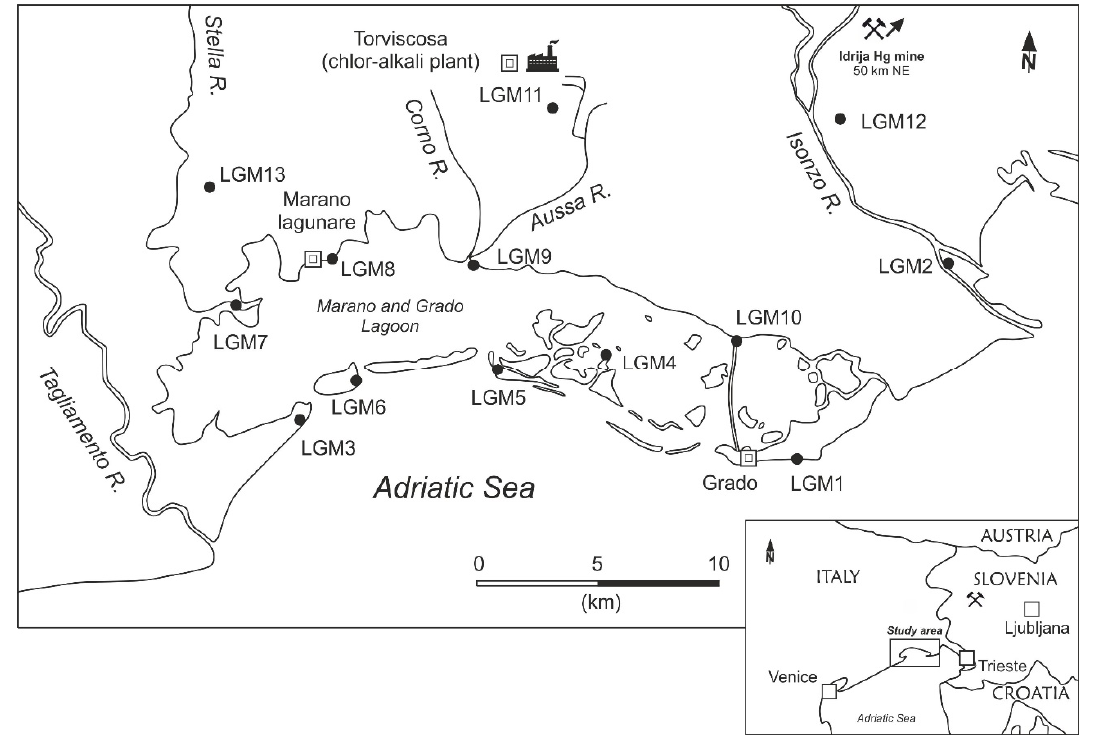
Figure 1. Study area of the Marano and Grado Lagoon, and selected sampling sites. The location of the Idrija Hg mine and the decommissioned chlor-alkali plant in Torviscosa are also indicated. Measurements were conducted by means of a Lumex RA-915M Portable Mercury